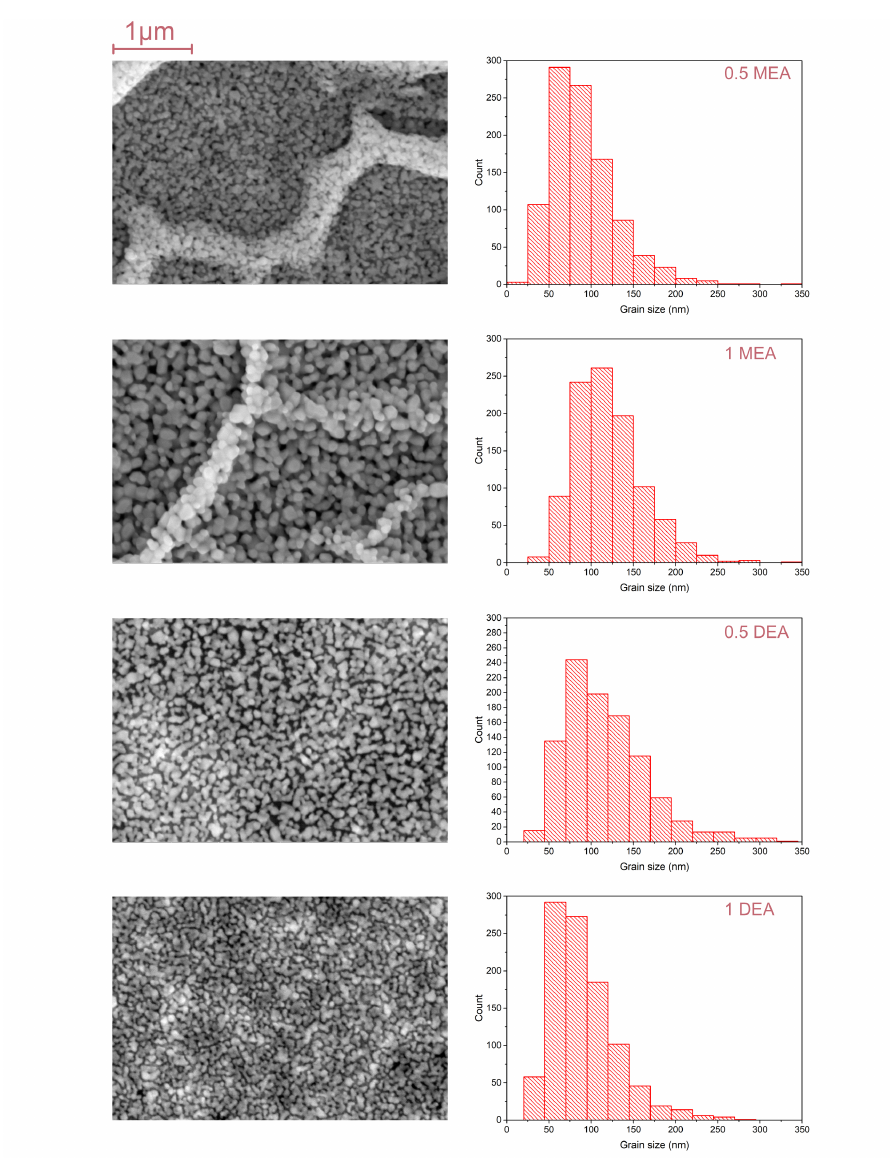
Figure 5. The SEM images and grain size distribution for ZnO layers grown on